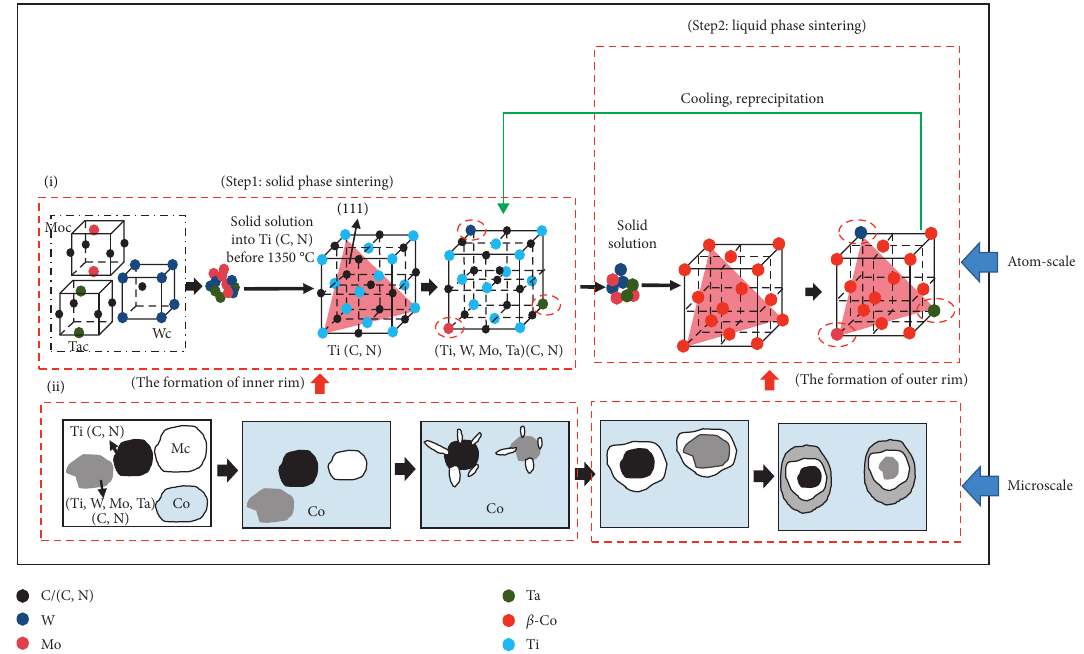
Figure 11: Formation process of the core-rim